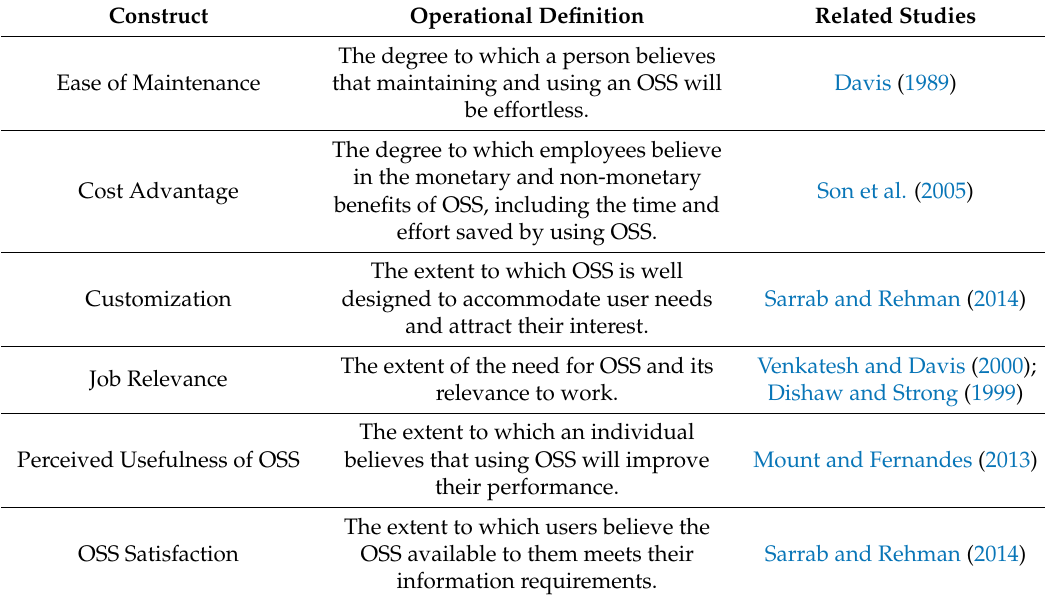
Table 2. Constructs and related